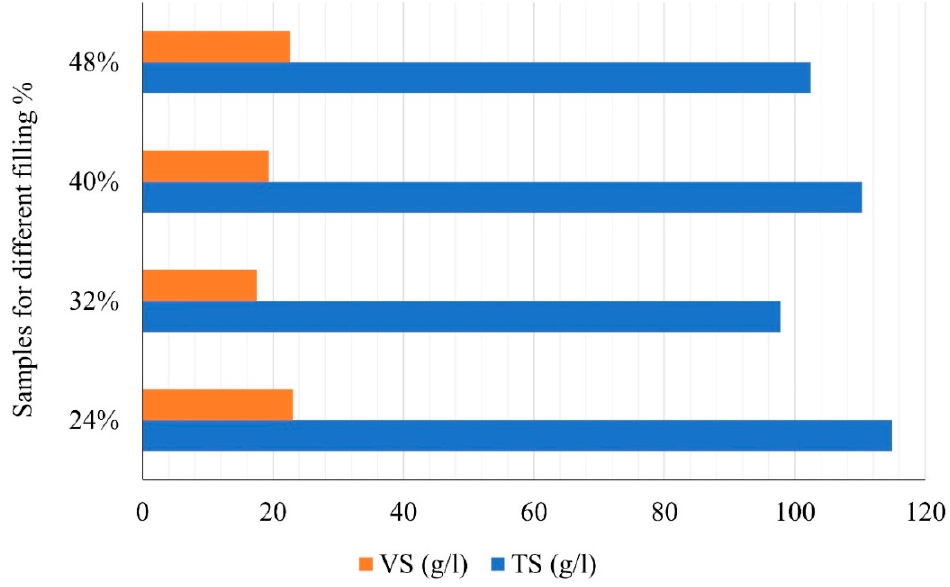
Figure 4. Total solids and volatile solids for different filling percentages of the HTC reactor.